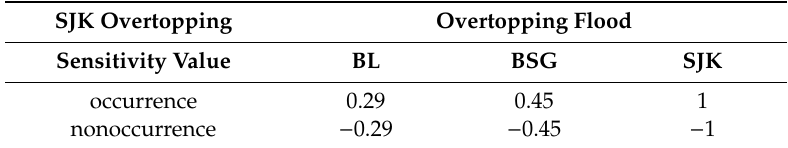
Table 6. The sensitivity analysis of SJK Overtopping, according to the Overtopping Flood node of each dam.